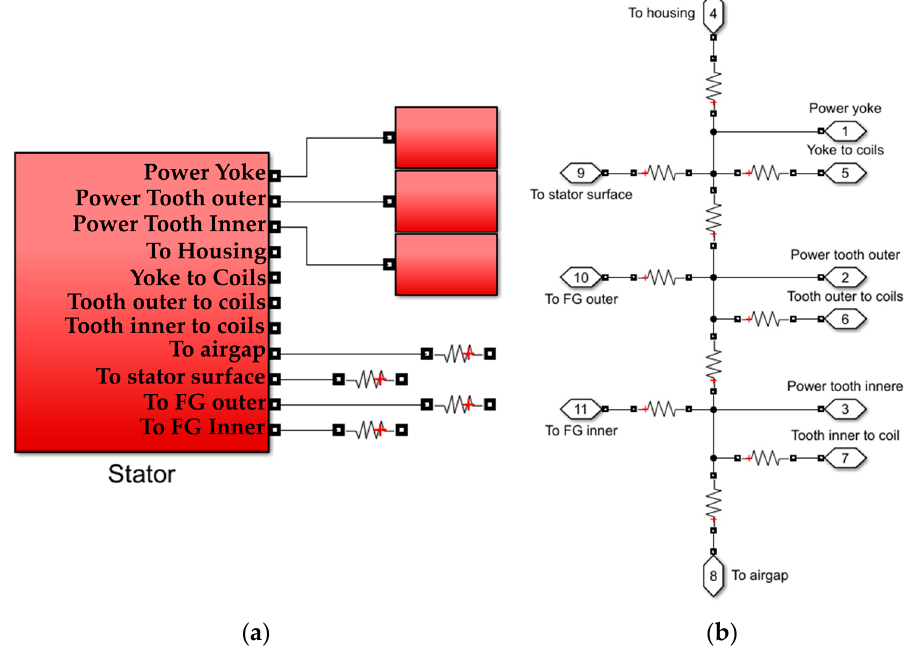
Figure 14. The 3D LPTN model for the stator for the modular machine. ( a ) Heat convection block. ( b ) Heat conduction block. FG is the flux gap.